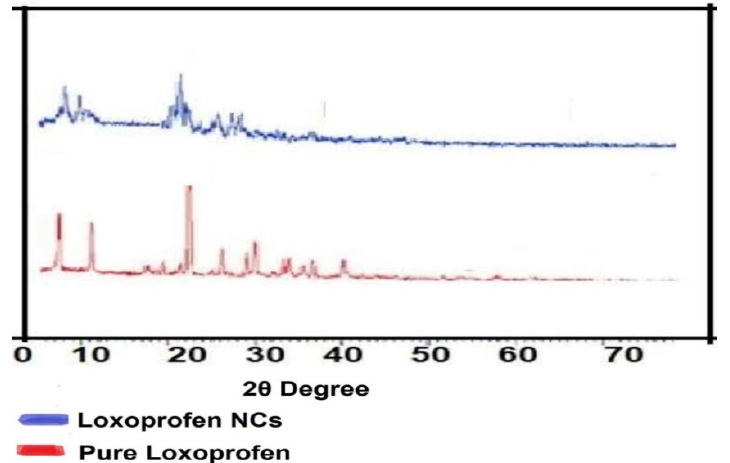
Figure 3. XRPD studies of LX